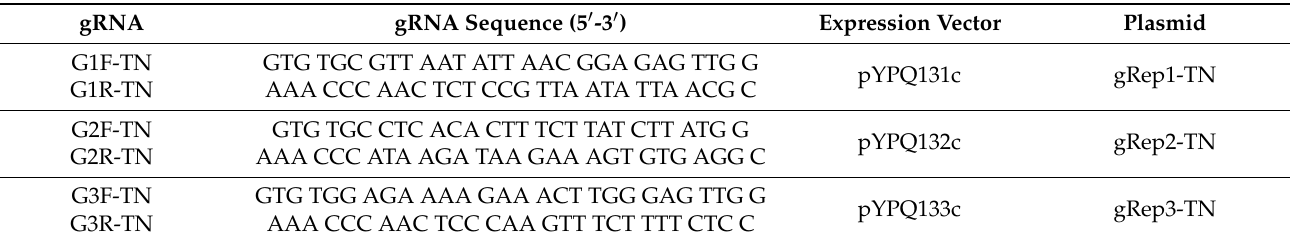
Table 2. gRNA sequences cloned into their respective expression